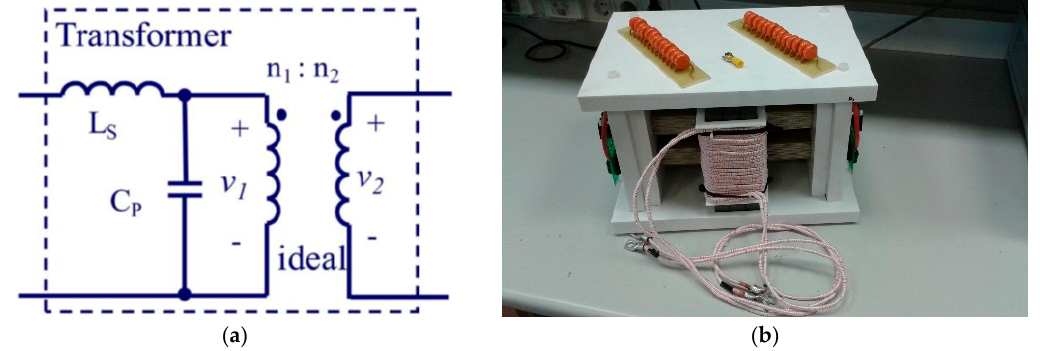
Figure 5. High-voltage transformer ( b ) and simplified equivalent circuit ( a ) of the step-up transformer.